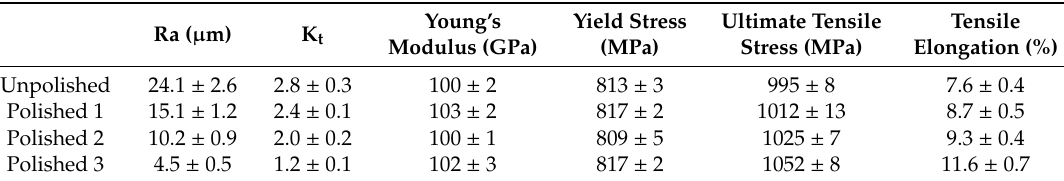
Table 1. Summary of physical properties of unpolished, polished 1, polished 2, and polished 3 tensile specimens. The polished 1, polished 2, and polished 3 samples are electropolished at a constant current density of 147, 294, and 442 mA / cm 2 , at 4 ◦ C for 20 min.